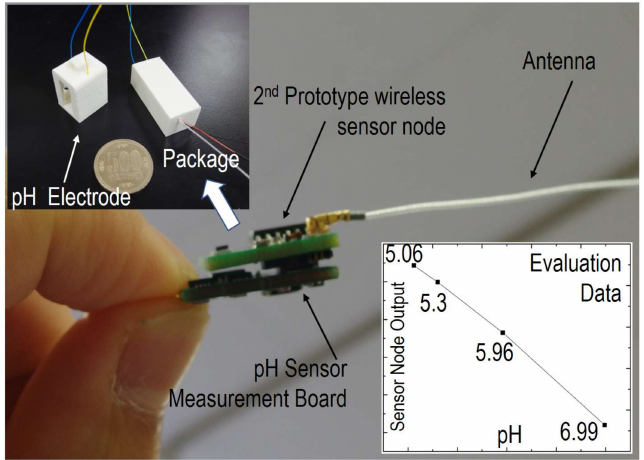
Figure 8. Photos of the developed fully solid wireless pH sensor before and after packaging. The inset shows the evaluation results collected by the wireless